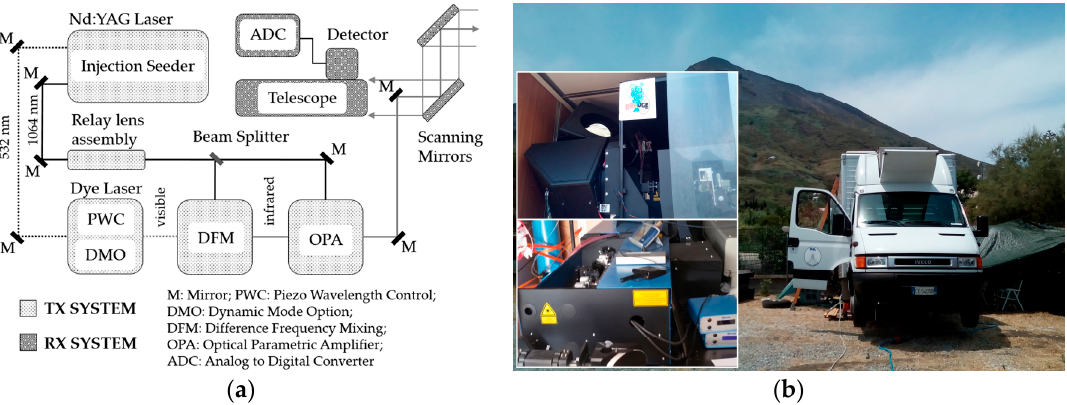
Figure 1. ( a ) Technical scheme of the BILLI DIAL system extrapolated and rearranged from the Figure 2 reported in [37]); ( b ) Experimental setup of the system during the Stromboli campaign (the volcano summit is visible above the two inset pictures). The scanning mirrors and the laser system are visible in the top and bottom inset picture, respectively.